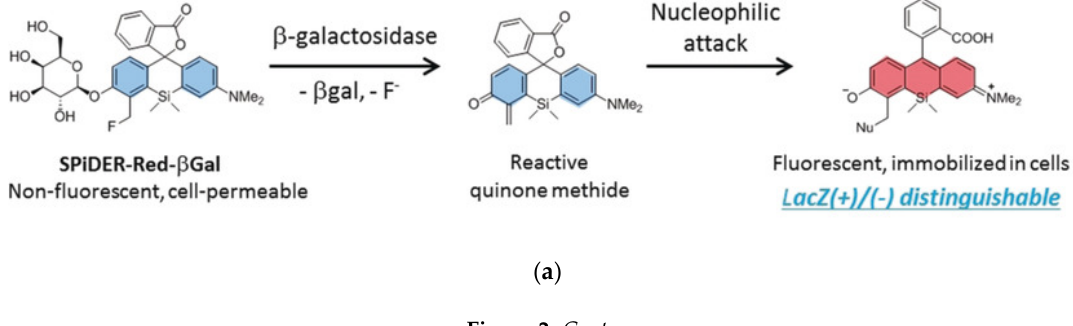
Figure 1. Si-based probe for the imaging of BACE1: ( a ) The activation mechanism of the probe; ( b ) the structure of the probe SiR-BACE1 and its analogues; ( c ) BACE1-EGFP transiently transfected HEK293T cells, stained with conjugates with different linker lengths (C2–C6, C8). Adapted with permission from [92]. Copyright (2018) American Chemical